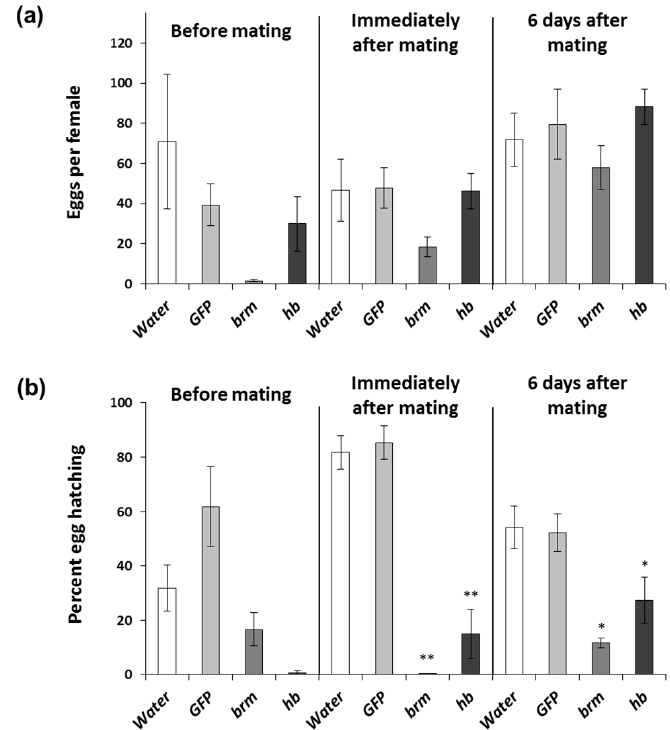
Figure 3. Timing of exposure effects on pRNAi response using brahma ( brm ) and hunchback ( hb ) dsRNA in D. v. virgifera. Females were fed diet with 2 µ g dsRNA six times before mating, six times immediately after mating, and six times six days after mating. Diet treated with water and GFP dsRNA were used as controls. ( a ) Eggs collected from dsRNA-fed females after last feeding exposure; ( b ) Eggs hatched based on the numbers oviposited. Comparisons performed with Dunnett ′ s test (control group = water), * significance at p < 0.05. ** significance at p < 0.001.